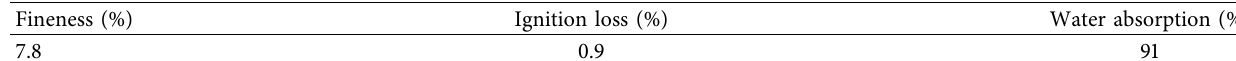
Table 3: Physical properties of mineral